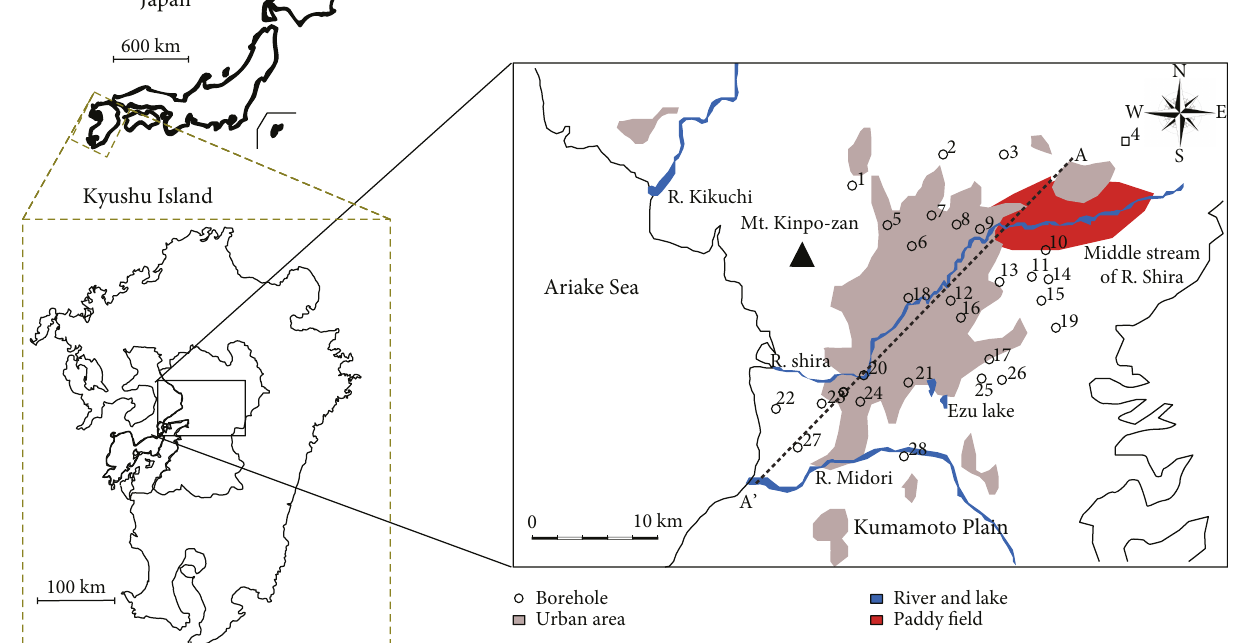
Figure 1: The location of the study area and the layout of monitoring